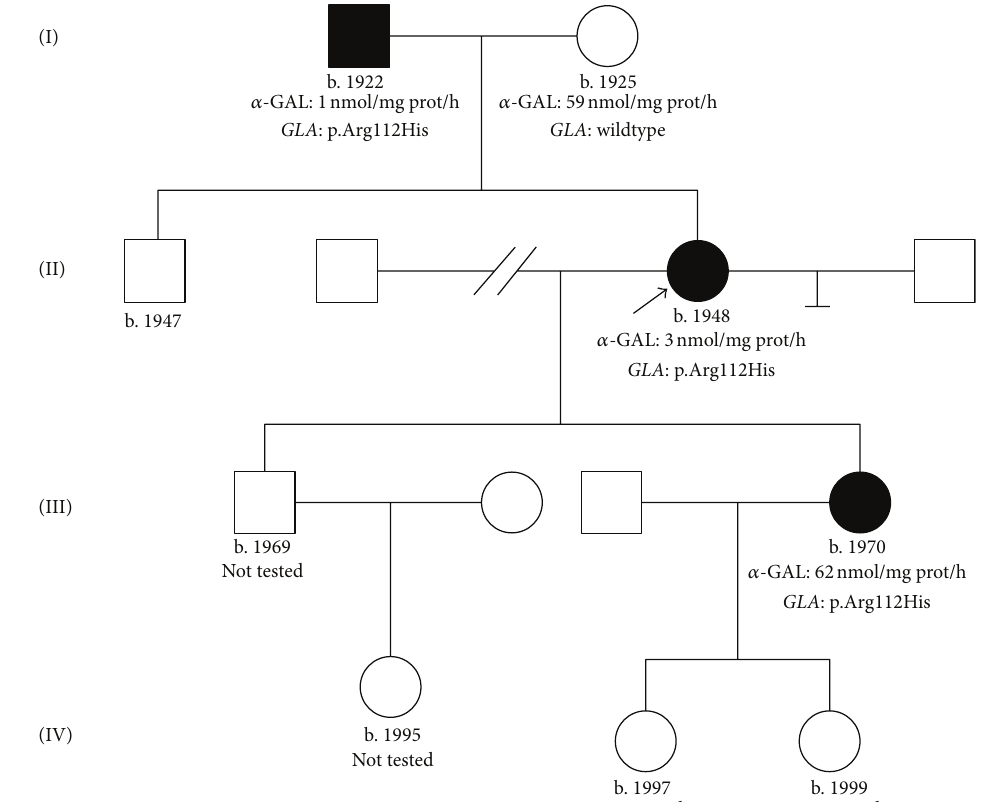
Figure 4: Pedigree. Latin letters indicate generations; ◼ indicates affected males; ◻ indicates unaffected males; ∙ indicates unaffected females; ∘ indicates unaffected females; ⊥ indicates no children; // indicates divorce; b.: year of birth; AGAL: 𝛼 -galactosidase A activity; GLA : respective GLA